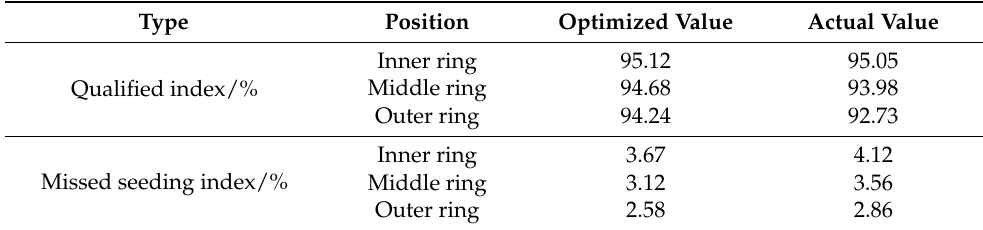
Table 7. Comparison of the optimized value and actual